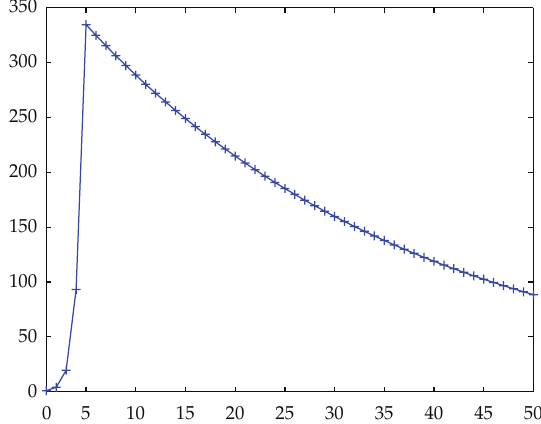
Figure 6: Virus population after optimal controls.